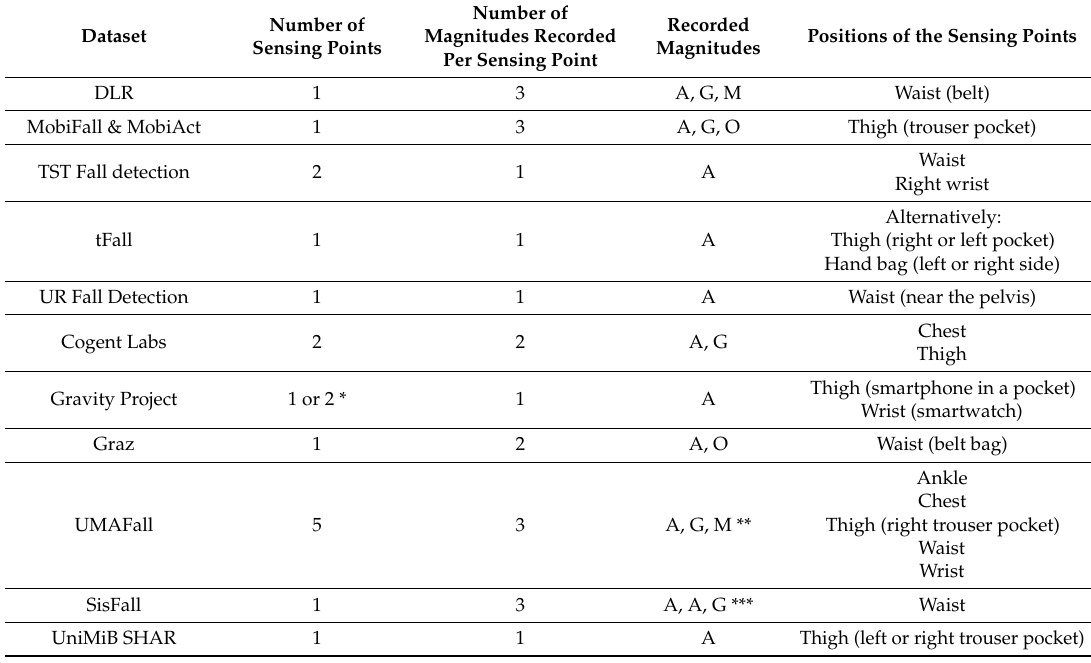
Table 7. Number, sensors, positions and measured magnitudes of the sensing